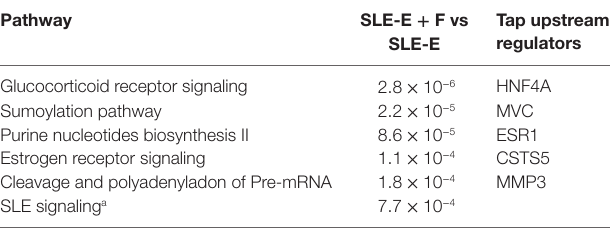
TaBle 3 | The top five canonical pathways affected by the estrogen receptor- alpha (ER α ) antagonist, Faslodex, in activated systemic lupus erythematosus (SLE) T cells.